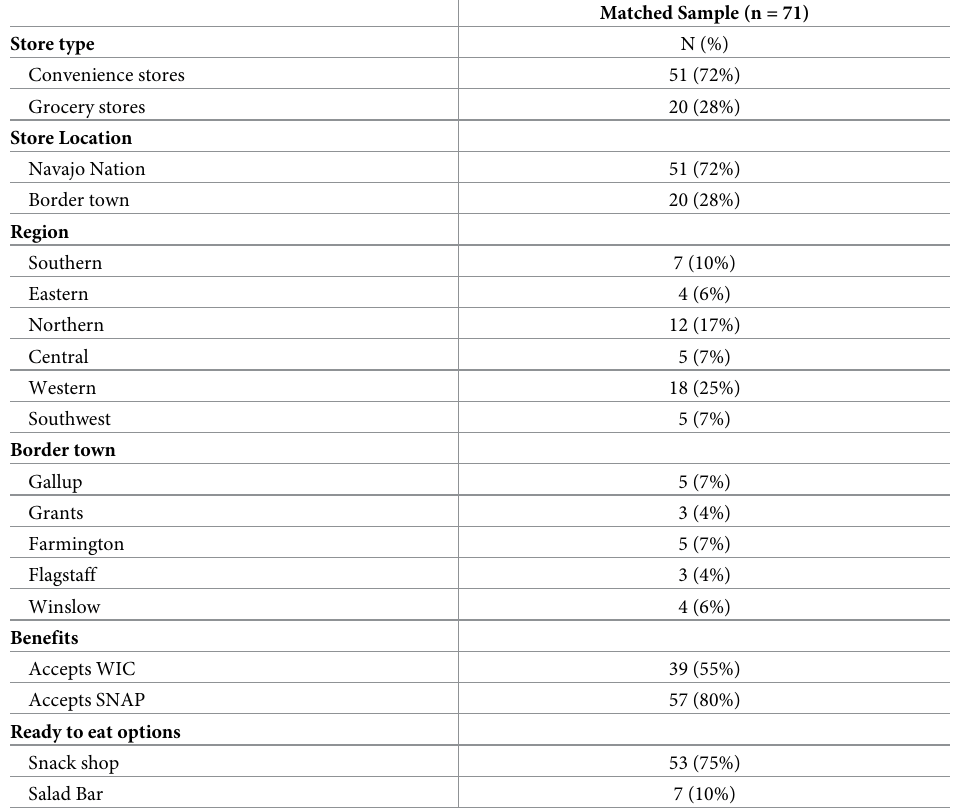
Table 1. Store characteristics of Navajo and border town stores, n =